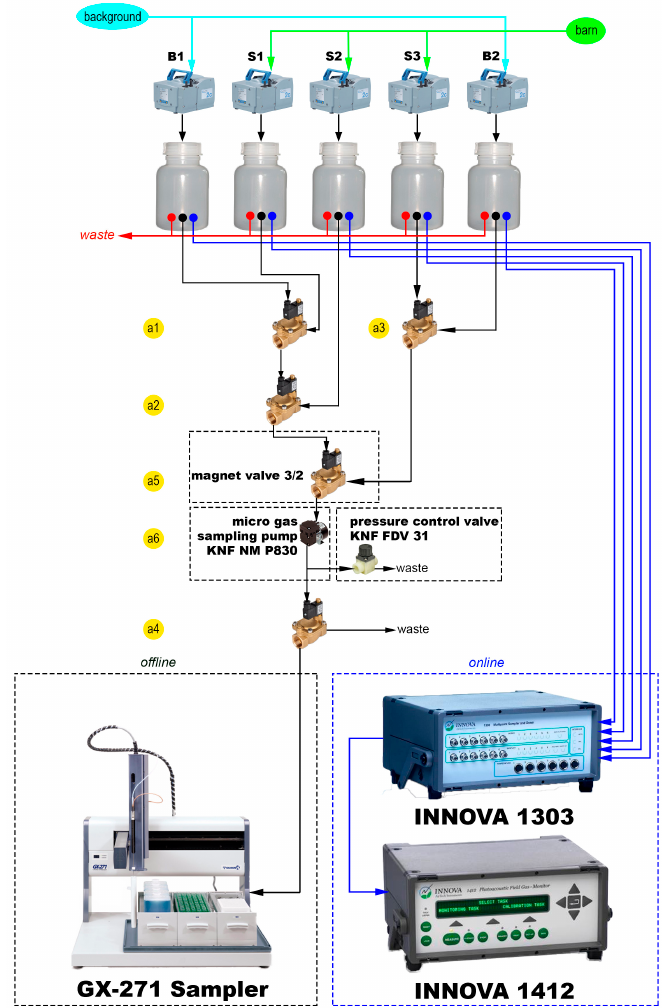
Figure 3. Schematic diagram of the experimental setup. Online: infrared photoacoustic measurement in real time; offline: samples analyzed using gas chromatography in the laboratory.